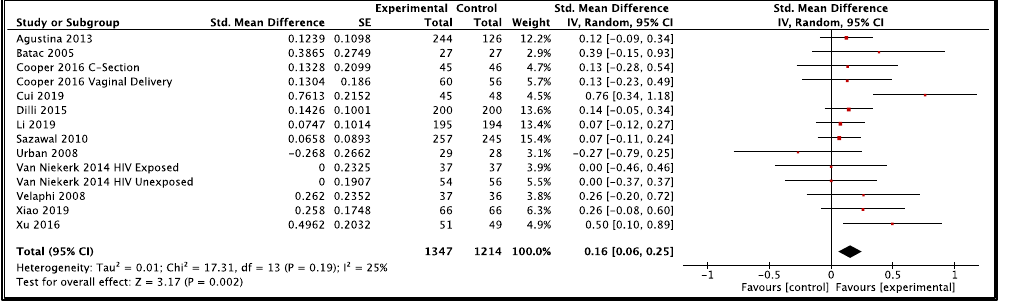
Table 2. Summary-of-Findings table showing results of GRADE analysis of overall evidence for effect of probiotics in children 0–59 months of age in high-income countries.